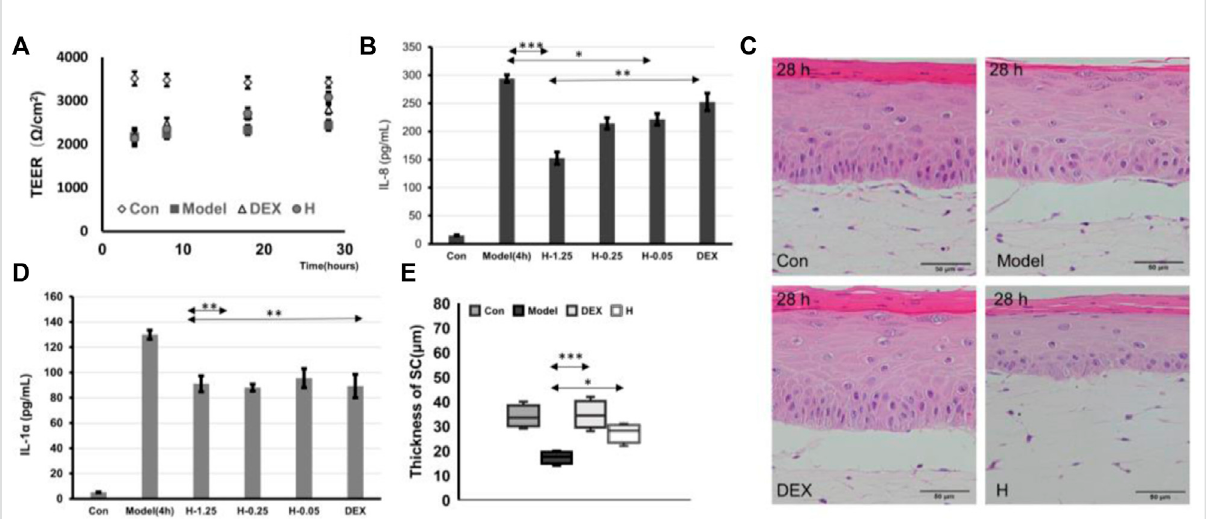
FIGURE 6 Drug testing. (A) TEER values of Con (treated with PBS) and model (treated with PBS for 24 h after SLS + P.acnes stimulation for 4 h), DEX (treated with dexamethasone for 24 h after SLS + P.acnes stimulation for 4 h), and H (treated with 1.25 μ M polyphyllin H for 24 h after SLS + P.acnes stimulation for 4 h). (B,D) Graphs showing the release of IL-1 α and IL-8 cytokines in response to stimulation in the model group and DEX group (treated with dexamethasone for 12 h after SLS + P.acnes stimulation for 4 h) and H-1.25, H-0.25, and H-0.05 (treated with 1.25, 0.25, 0.05 μ M of polyphyllin H for 12 h after SLS + P.acnes stimulation for 4 h). (C,E) H&E cross section (C) and the thickness of the stratum corneum (E) of Con, model, + DEX, and + H in (A) ( n = 5 per condition, p * < 0.05; p ** < 0.01; p *** <